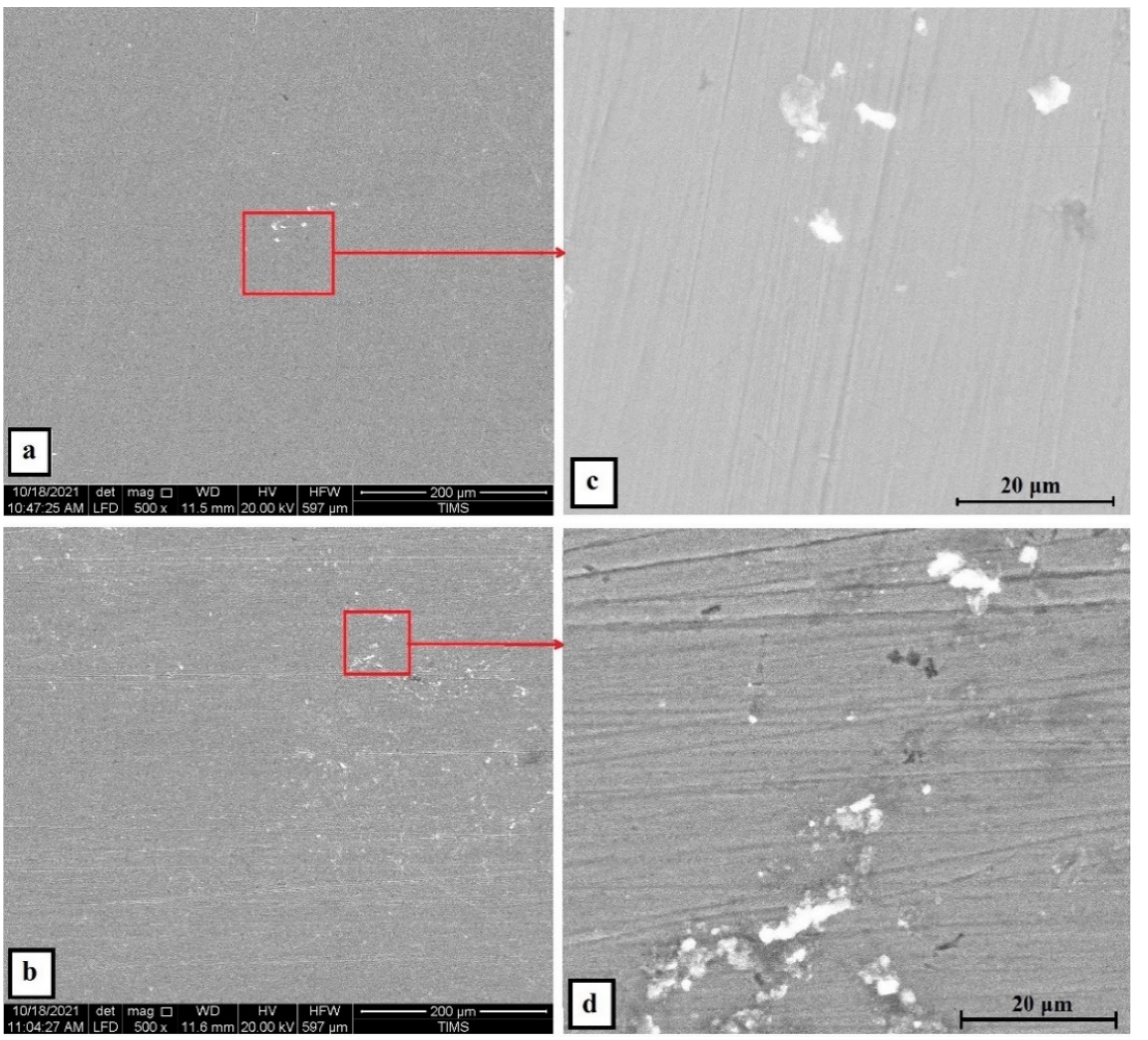
Table 2. EDX analysis of the corrosion products on the surface of cold-rolled and solution-treated